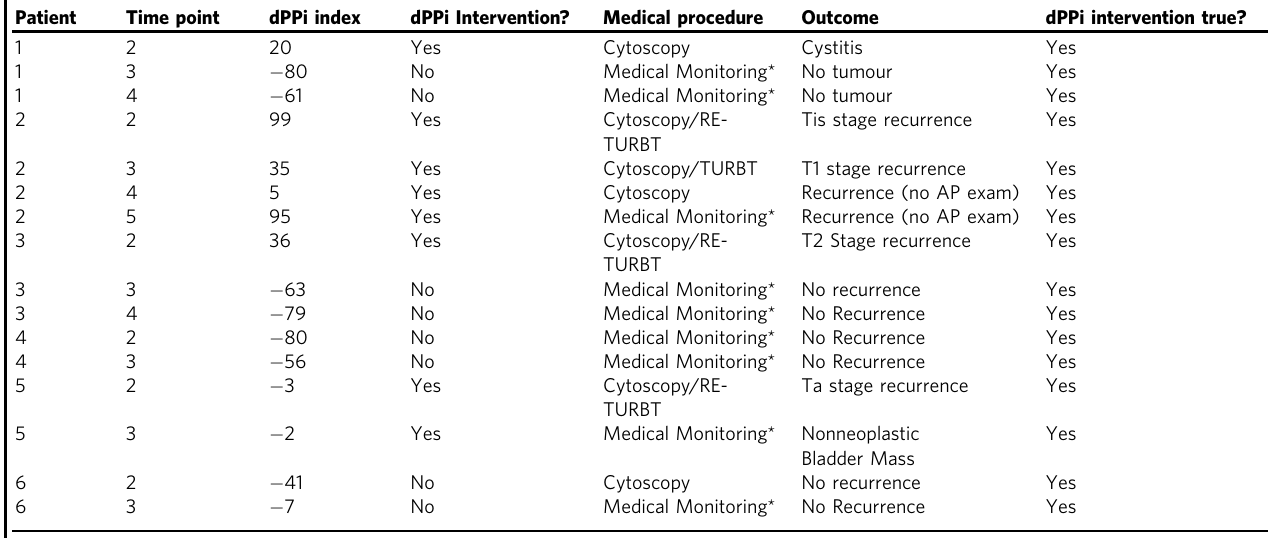
Table 2 The dPPi index column shows the index calculated as explained in the methods section.